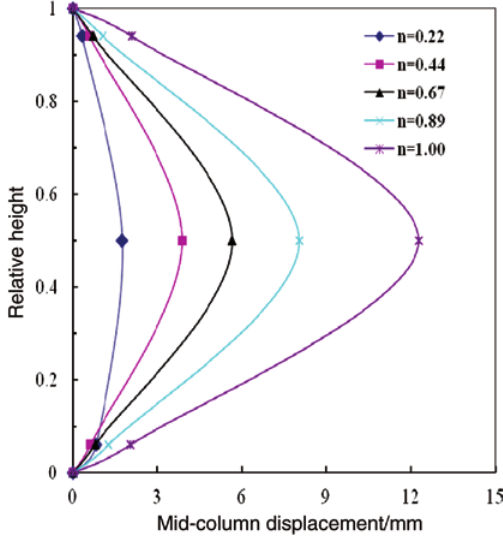
Figure 13: Illustration of lateral deflection under a bias load.